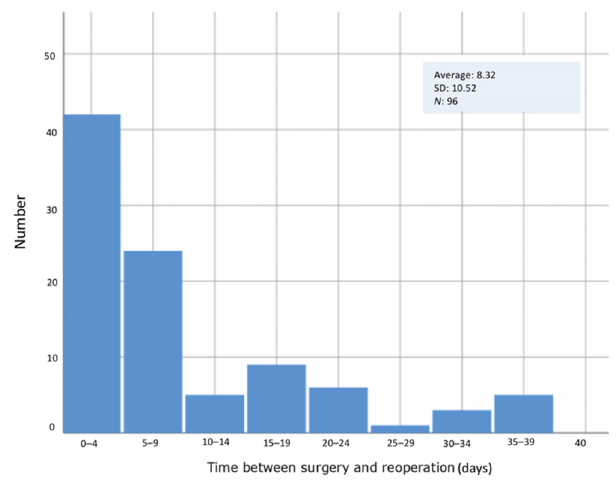
Figure 1. Interval between the day of the surgery and